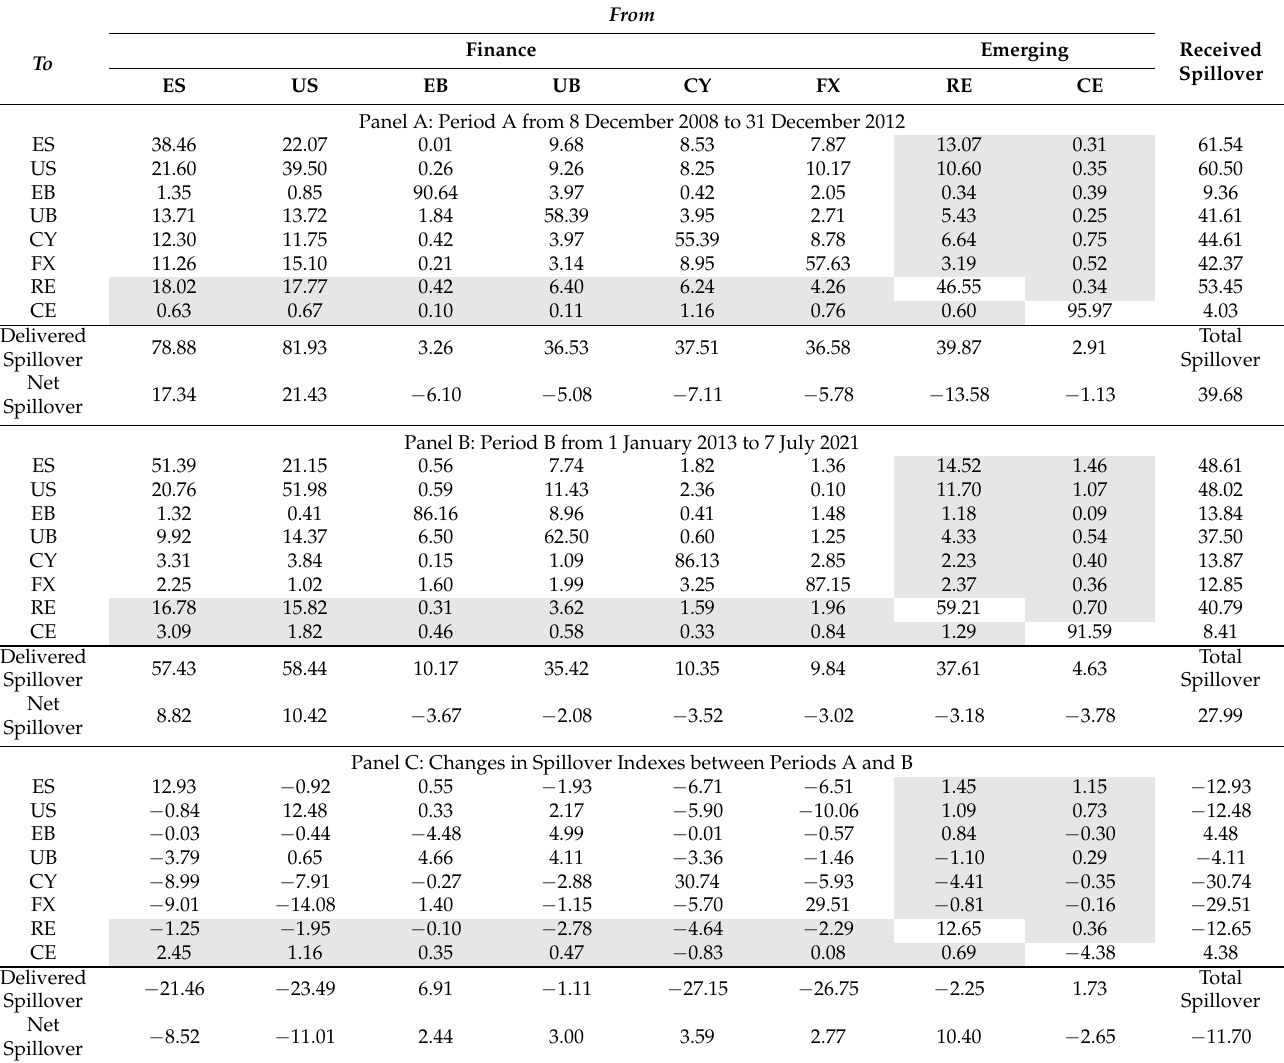
From Finance Emerging Received